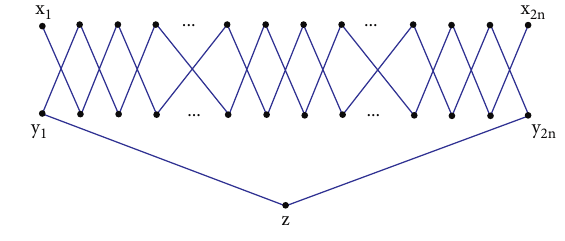
Figure 1: A Hamilton path from A to B .